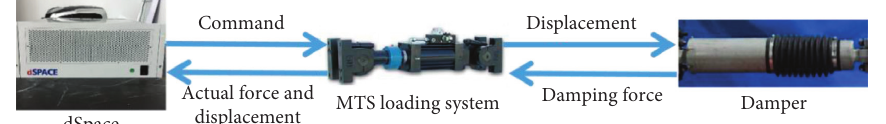
Figure 2: Schematic of the testing system for